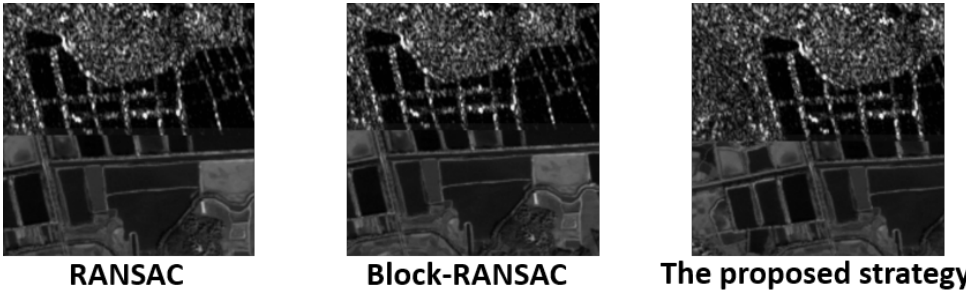
Figure 17. Details of image transformation relationships detected by RANSAC, Block-RANSAC and the proposed strategy in pair